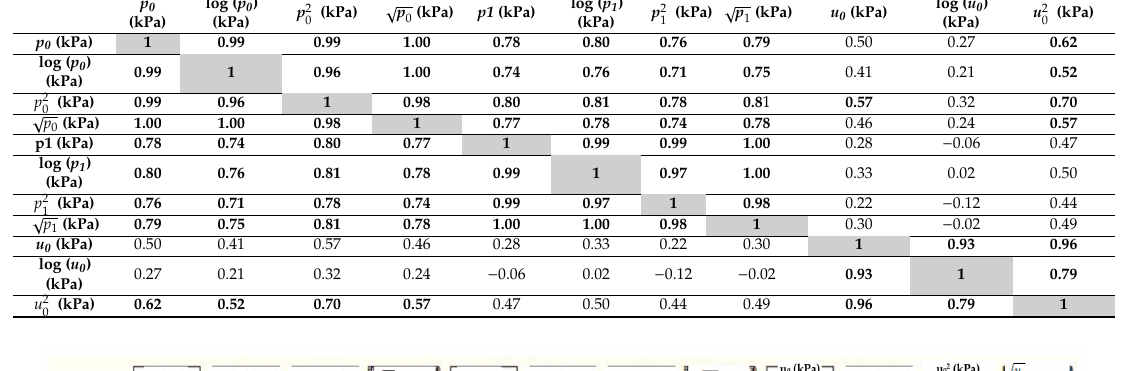
Table 7. Correlation for selected variables from Table 2.